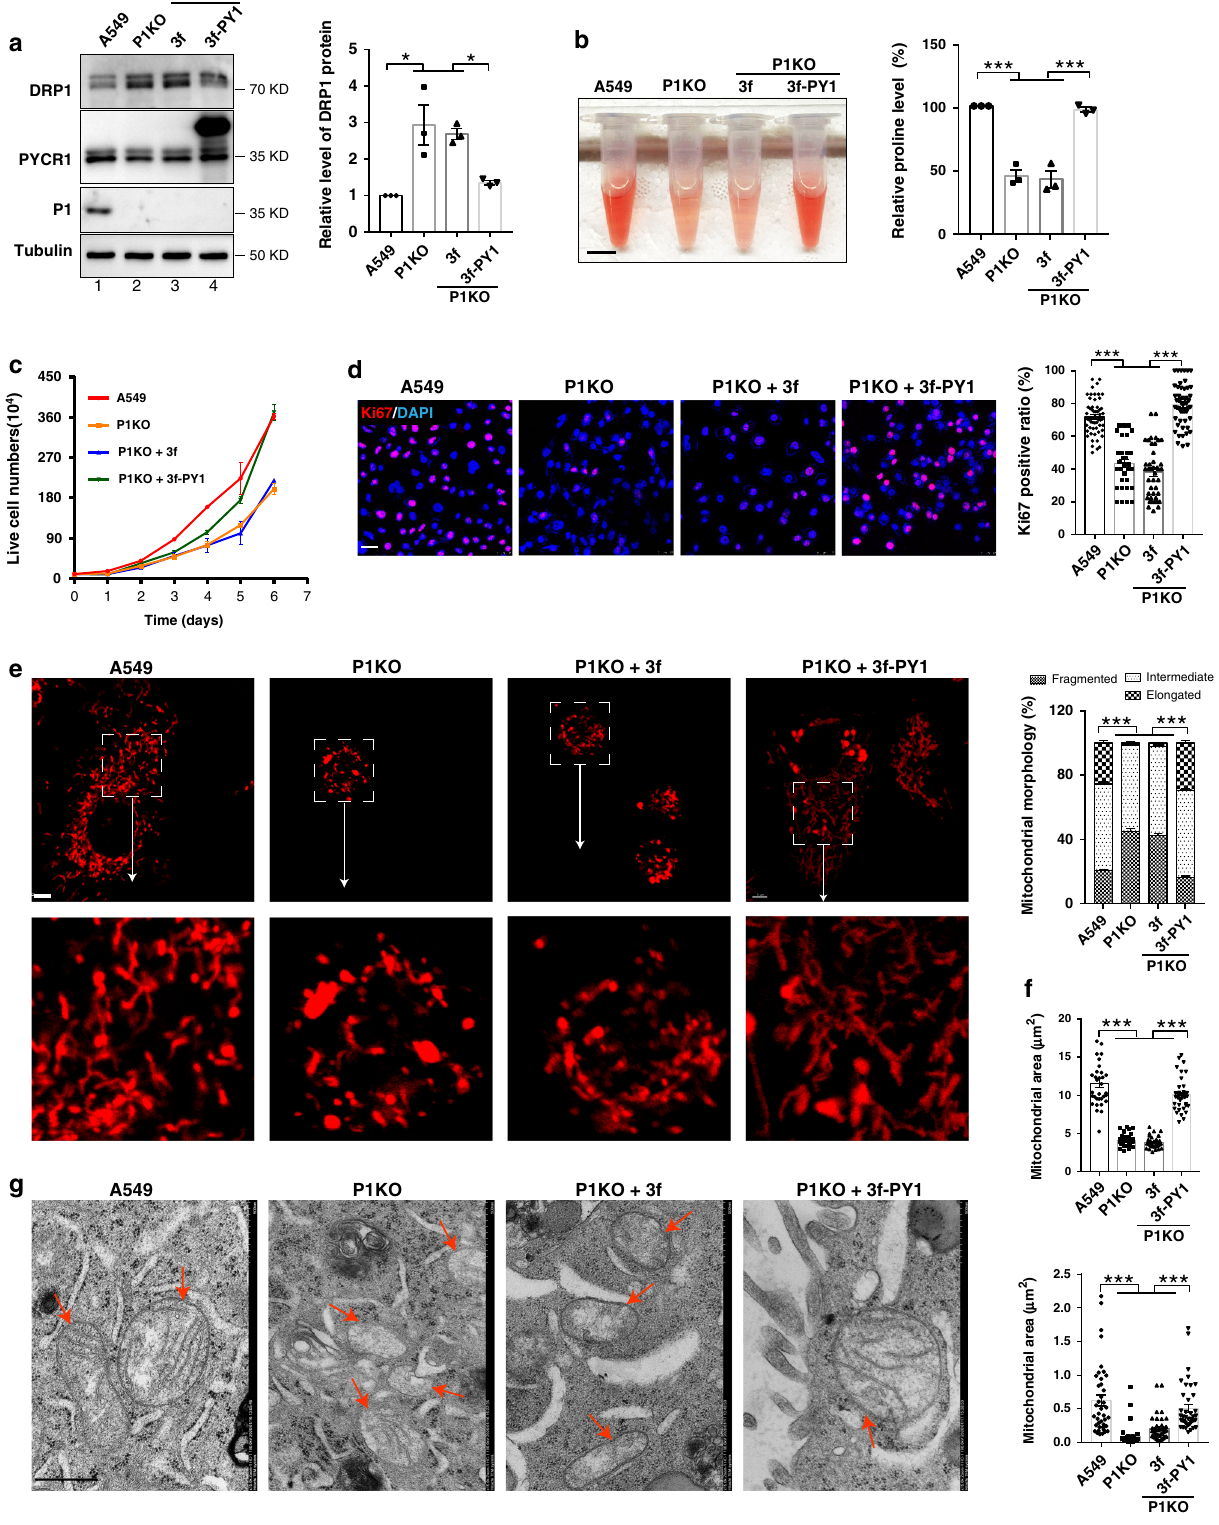
RT-PCR analysis . cDNA was synthesized from 10ng total RNA using the Rever- Tra ® Ace qPCR RT Master Mix (Toyobo Life Science, Osaka, Japan) according to the manufacturer ’ s protocol. RT-PCR was performed using SYBR ® Premix Ex Taq ™ II with LightCycler ® 480 Instrument II System. For quantifying DRP1 mRNAs,